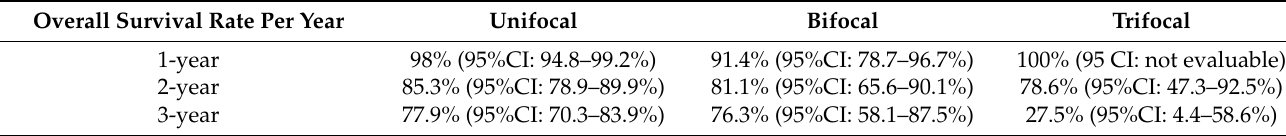
Table 5. Overall survival per year for each uni-, bi-, trifocal